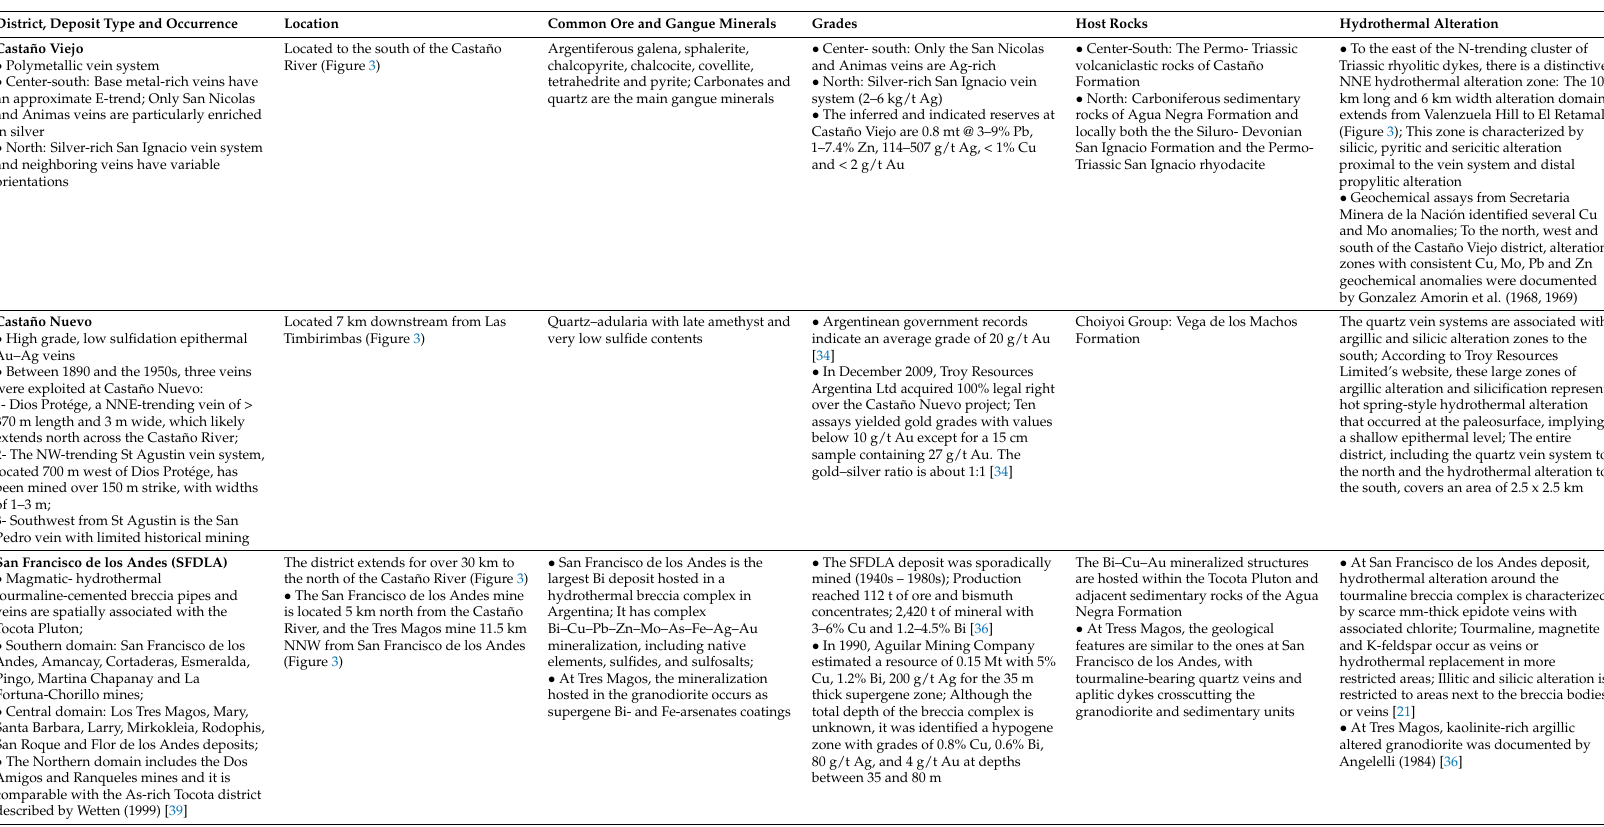
Table A2. Summary of key mineralogical, hydrothermal alteration and geological features that characterize known ore deposits and geochemical anomalies located within the studied ASTER scene. Table based on selected literature